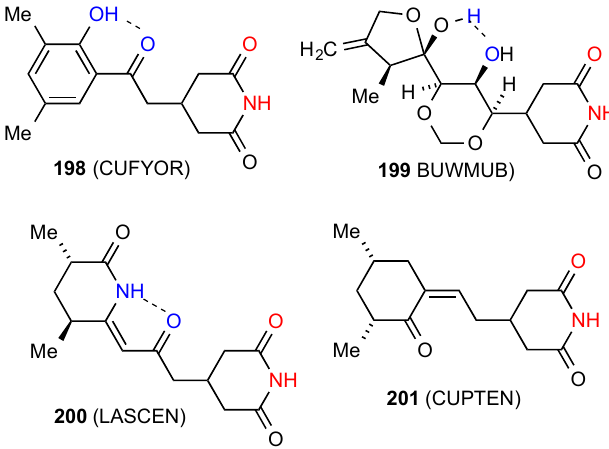
Figure 61. 4-Monosubstituted glutarimides of patterns A and B.